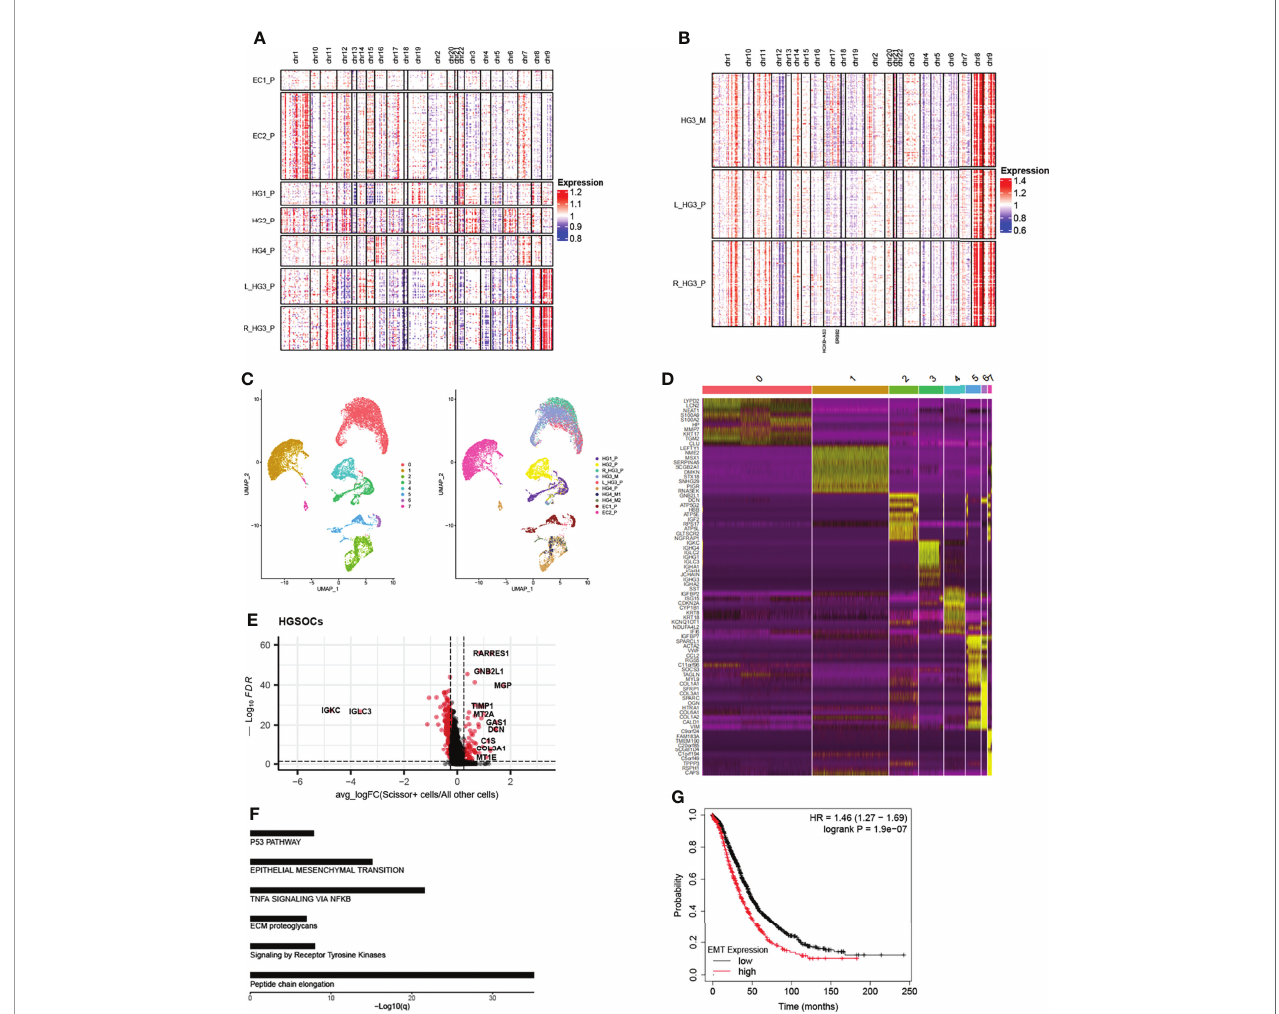
FIGURE 2 | Copy number pro fi les, intertumoral heterogeneity, and EMT signature subpopulations are identi fi ed. (A) The chromosomal landscape of copy number for 13,634 epithelial cells of seven primary tumors; ampli fi cation (red) and deletions (blue). (B) The chromosomal landscape of copy number for 2849 epithelial cells of metastatic tumors and primary tumors of the HG3 patient (L_HG3_P means the primary tumor from the left ovary in the HG3 patient; R_HG3_P means the primary tumor from the right ovary in HG3 patient). (C) The UMAP projection of 17,551 epithelial cells from 10 tumors of six patients (indicated by labels and colors) reveals tumor-speci fi c clusters. (D) Differentially expressed genes of the top 10 genes (rows) that are differentially expressed in each cluster (columns). (E) Differentially expressed genes between Scissor + cells and all other cells in HGSOCs, each point represents a gene. Red: signi fi cant genes; Black: NS genes. avg_logFC: log 2 fold-change of the average expression between the two groups. ((log-FC > 0.25, FDR <0.05) (F) Enrichment of signi fi cant genes related to Reactome and Hallmark pathways. (G) Kaplan-Meier plot shows that high expression of EMT signature has shorter overall survival in ovarian cancer. The high and low patients are split by the mean expression of the EMT-related gene